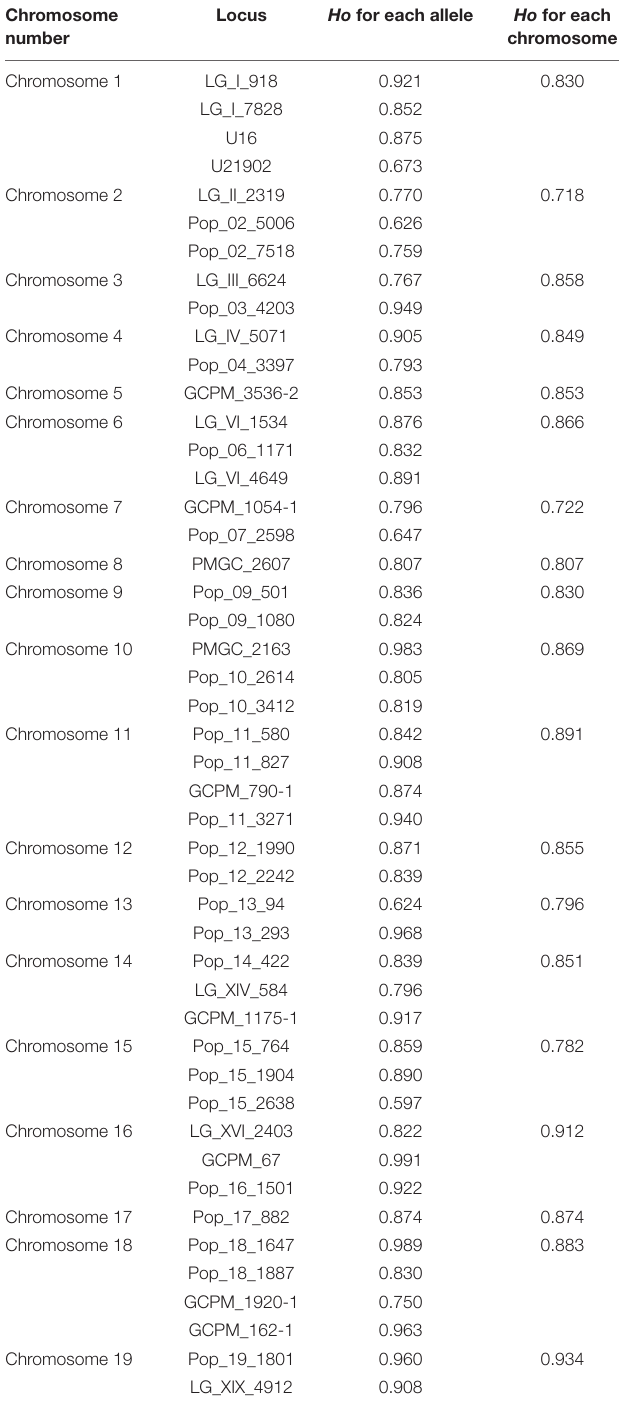
TABLE 1 | Heterozygosity analysis of each simple sequence repeat (SSR) loci and each chromosome for the mixed ploidy progeny. Chromosome Locus Ho for each allele Ho for each number